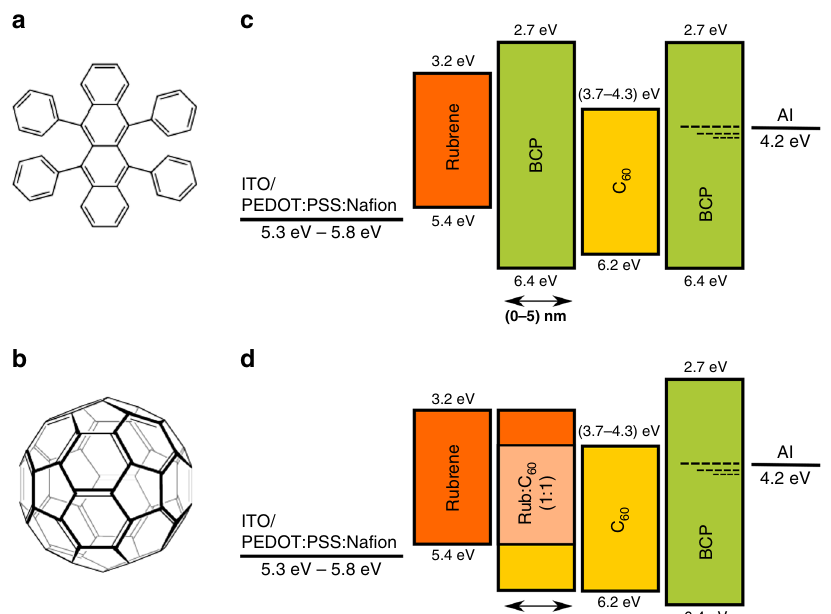
Fig. 1 Molecular structures and energy level diagrams. Molecular structures of ( a ) rubrene and ( b ) C 60 . Energy level diagrams of devices with ( c ) BCP interlayer and ( d ) mixed rubrene:C60 (1:1) interlayer. Highest occupied molecular orbital (HOMO) and lowest unoccupied molecular orbital (LUMO) values for rubrene and C 60 taken from refs. 6,7,10,51 , BCP values taken from refs. 18,19 . Range of commonly reported work functions for PEDOT:PSS:Na fi on, for 10% Na fi on, the expected work function is near 5.5 eV 11 –